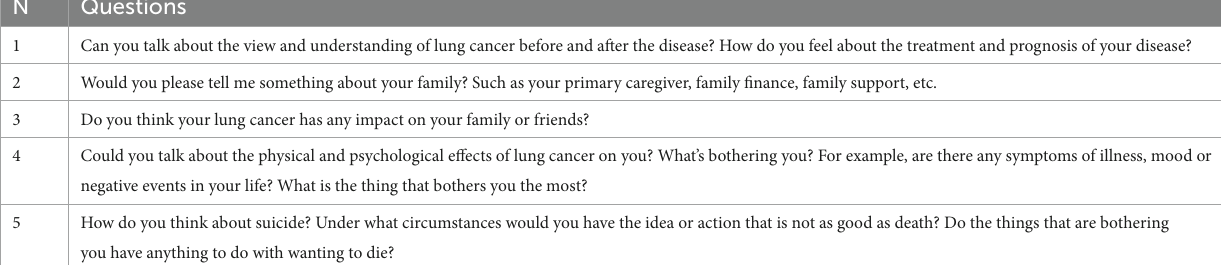
TABLE 1 Semi-structured interview